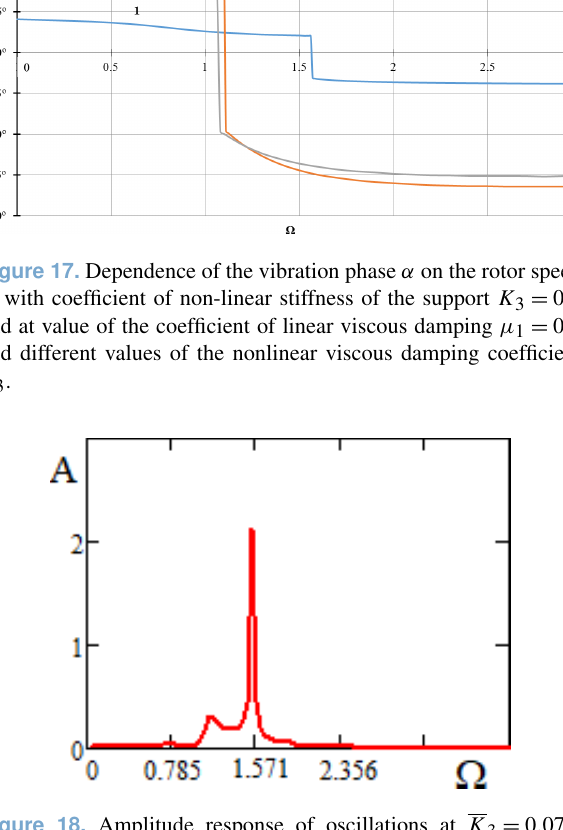
Figure 18. Amplitude response of oscillations at K 3 = 0 . 075, µ 1 = 0 . 09, µ 3 =